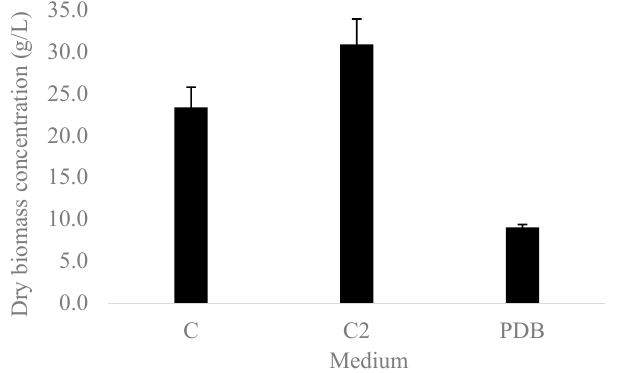
Figure 1. Dry biomass concentration obtained after 14 days in the optimized medium (C), optimized medium supplemented with 9.1 g/L olive oil (C2), and commercial potato dextrose medium (PDB). Error bars indicate the standard deviation of three independent replicates.